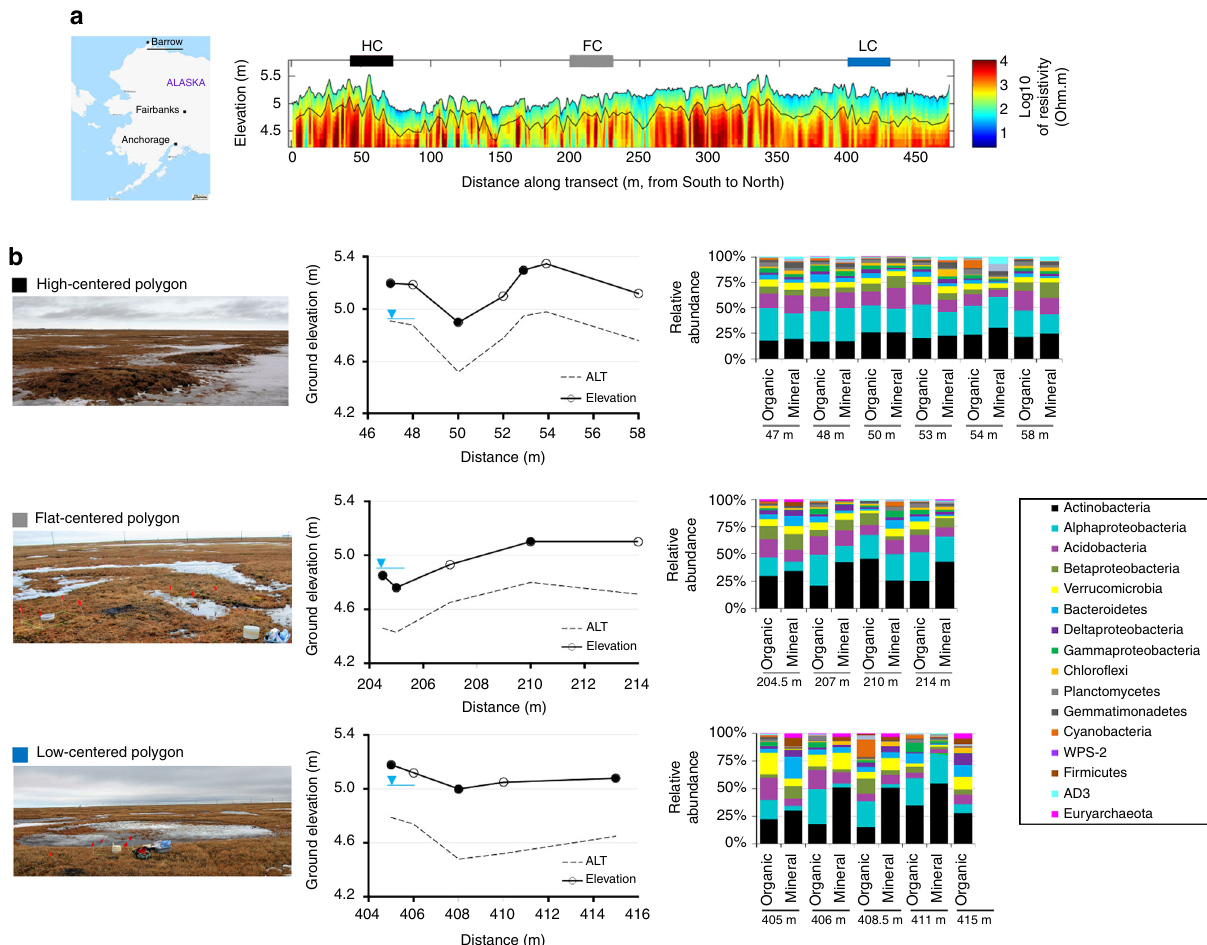
Fig. 1 Microbial communities of active layer are strongly correlated to landscape topography in arctic polygonal tundra. Samples were collected from active layer soils and permafrost layer along a transect of high- (black), fl at- (gray) and low- (blue) centered polygons located at Barrow Experimental Observatory. Map is adapted from ©OpenStreetMap contributors, licensed CC-BY-SA. a Electrical resistivity tomographic (ERT) data were, collected along the ~480 m transect, coincident with soil core retrieval and many different types of in situ soil measurements. ERT data were used to characterize deeper permafrost variability and ice-wedge structures (deeper yellow-red-blue), as well as active layer variability (blue-green). Along this ERT transect, the fi rst 0 – 150 m were dominated by HC polygons (black bar) which transitioned to FC (gray bar) and LC (blue bar) polygons afterwards. ERT and soil characterization data are described elsewhere 1 . b Photographs (taken by the authors) show the differences in surface soil morphology among different polygon types. In HC polygons centers and troughs could have an elevation difference up to 0.6 m whereas elevation difference among rims, troughs, and centers of FC and LC polygons vary between 0.1 – 0.3 m. We collected samples for sequencing of the microbial community composition along the polygonal transect (circles show the sampling locations). Active layer thickness (ALT) was also measured at each sampling point. Water table (blue upside down triangle) levels are inferred from measured water levels in troughs and soil moisture measurements and show an estimated depth. CO 2 and CH 4 fl uxes were measured in two consecutive years, 2012 and 2013 from rims, troughs, and centers of polygons (closed circles; Supplementary Fig. 9